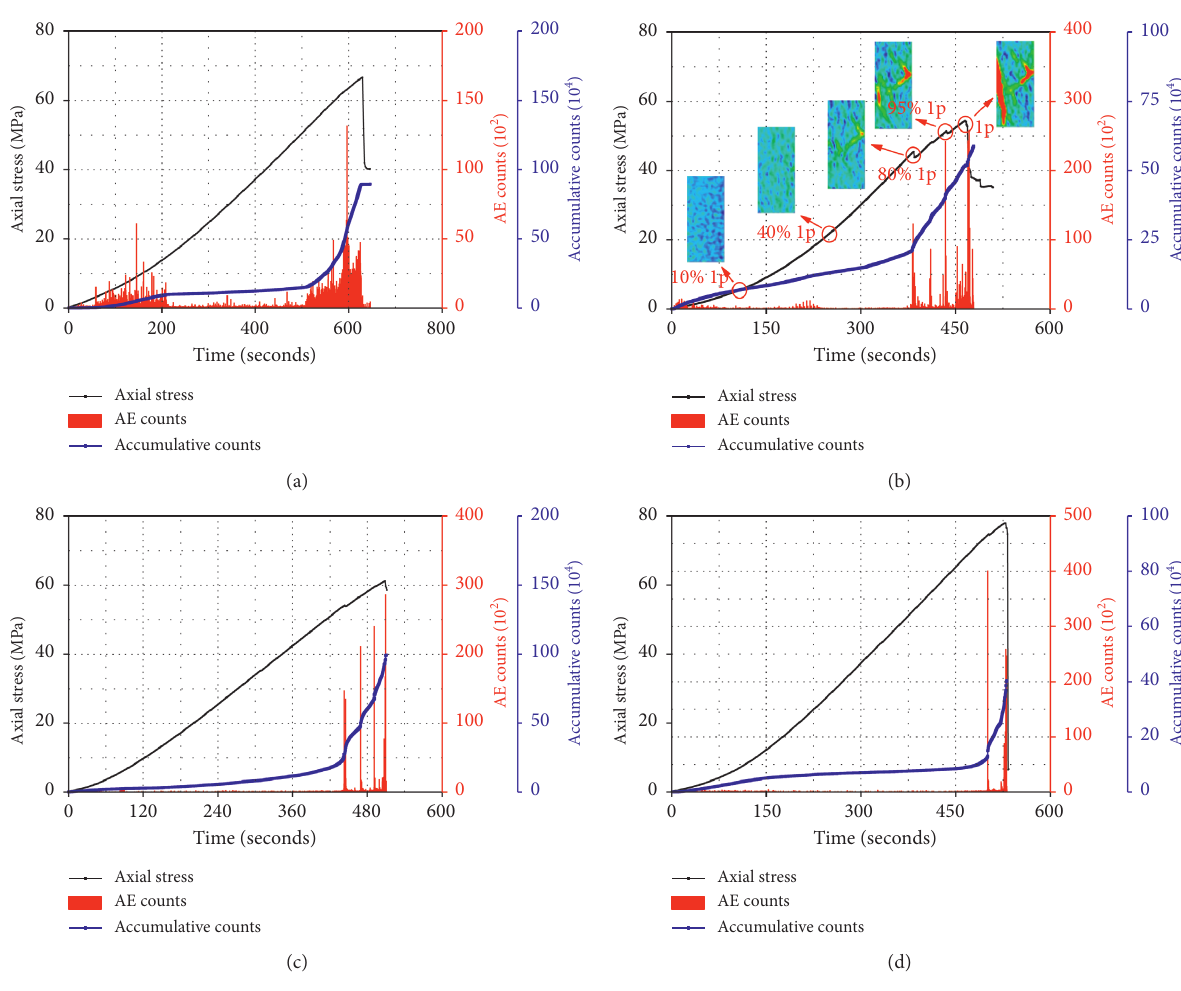
Figure 11: AE curves of specimens containing rough joint with different joint inclinations, i.e., (a) specimen T30-2# ( α � 30 ° , l � 40.0 mm), (b) specimen T45-2# ( α � 45 ° , l � 40.0mm), (c) specimen T60-2# ( α � 60 ° , l � 40.0mm), and (d) specimen T90-1# ( α � 90 ° , l � 40.0mm) under uniaxial